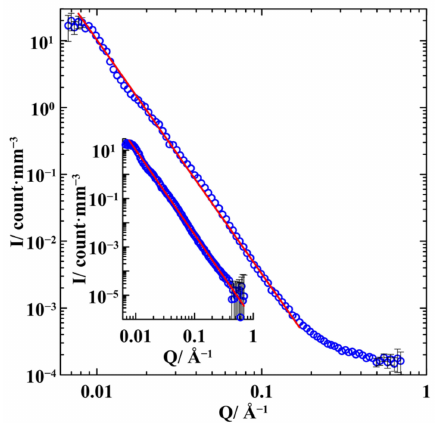
Figure 2. Normalized SANS intensity in the empty porous glass. The inset shows the SANS intensity after subtracting the background and incoherent scattering. The straight lines correspond to the I ~ Q − 3.5